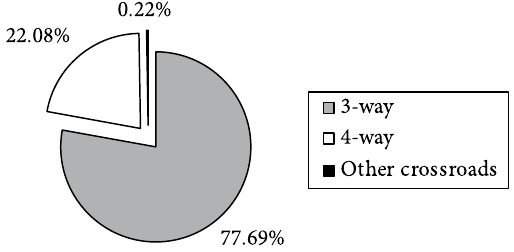
Fig. 5. The repartition of the same level crossroads in Lithuanian main and interurban road networks